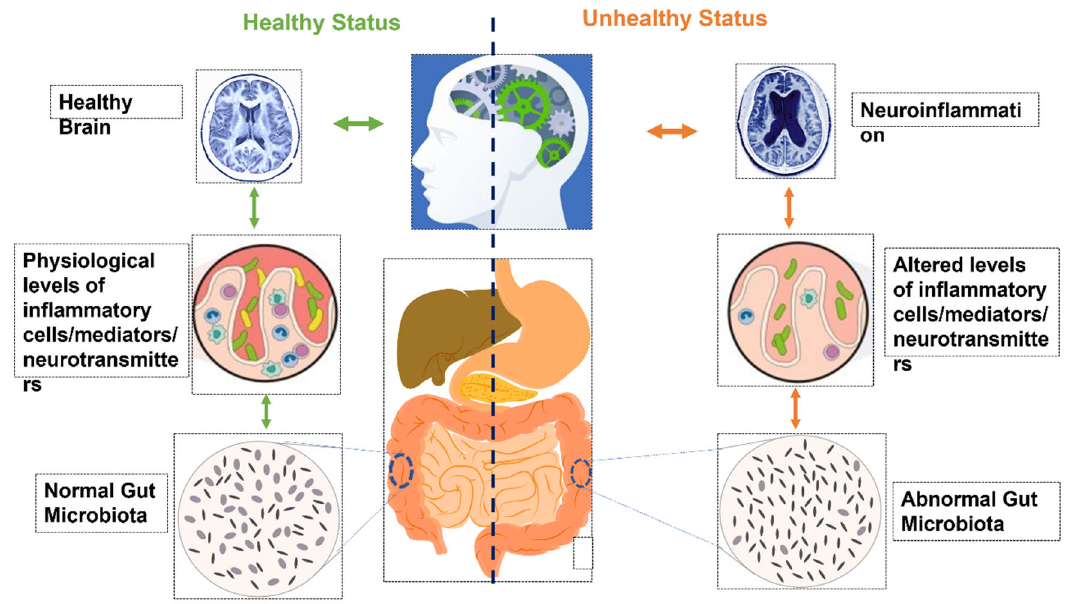
Figure 1. Illustration of the impact of the gut microbiome on neuroinflammation. Human microbiota or gut microbiota is the plethora of microorganisms with a higher amplitude of bacteria inhabiting primarily on the surface of the oral mucosa or of the in ‐ testines. The microbiome and the host organism maintain a mutually beneficial or symbi ‐ otic relationship [11]. The genome of these microscopic creatures is estimated to be more than the genome of the host under the radar, the human [12]. Recent studies indicated that the human body accommodates approximately 3.8 × 10 12 bacterial cells, with a wide range